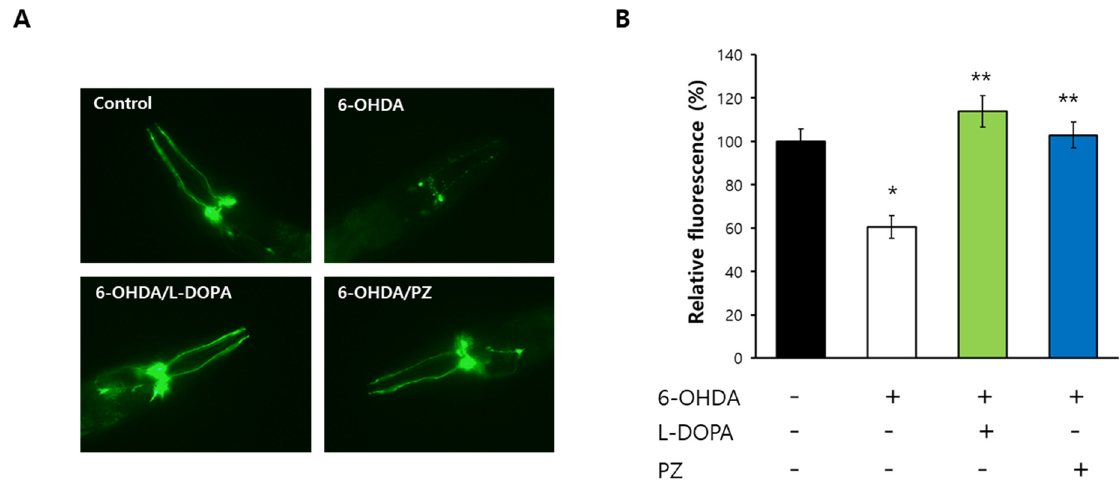
Figure 6. Inhibited degeneration of dopaminergic neurons by phlorizin. ( A ) GFP expressed in dopaminergic neurons was observed for untreated control, 6-OHDA-treated, 6-OHDA/L-DOPA-treated, and 6-OHDA/phlorizin-treated groups under a fluorescence microscope. ( B ) Quantification of fluorescence in the anterior head region was performed using image J program. Error bar indicates standard error. *, a significant difference ( p < 0.05) compared to untreated control; **, a significant difference ( p < 0.05) compared to 6-OHDA-treated group; 6-OHDA, 6-hydroxydopamine; L-DOPA, L-3,4-dihydroxyphenylalanine; PZ, phlorizin (10 μ M).